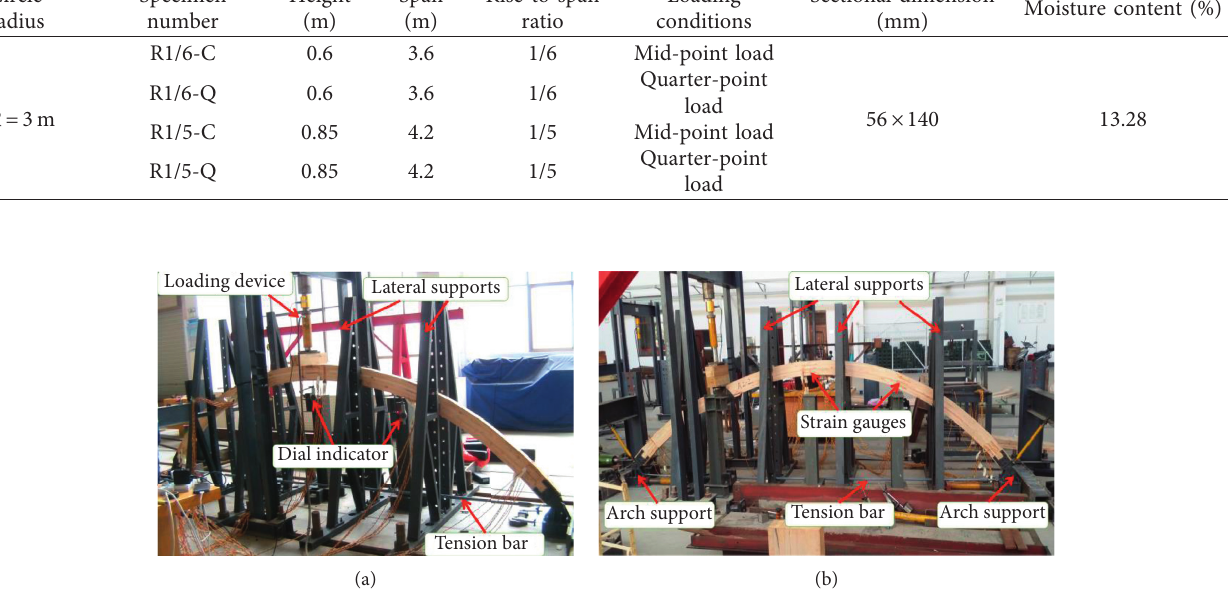
Figure 3: Experimental setup: (a) mid-point and (b) quarter-point loading